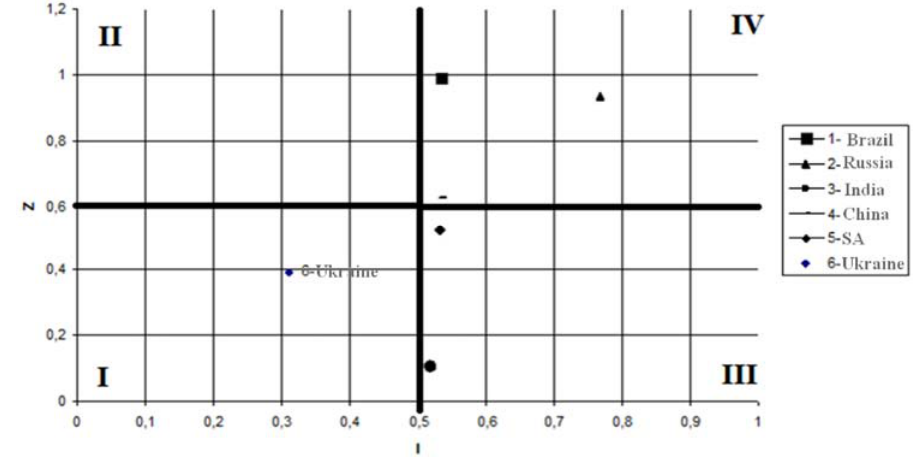
Fig. 4. Strategic positioning of Ukraine and member countries of BRICS in the third year of